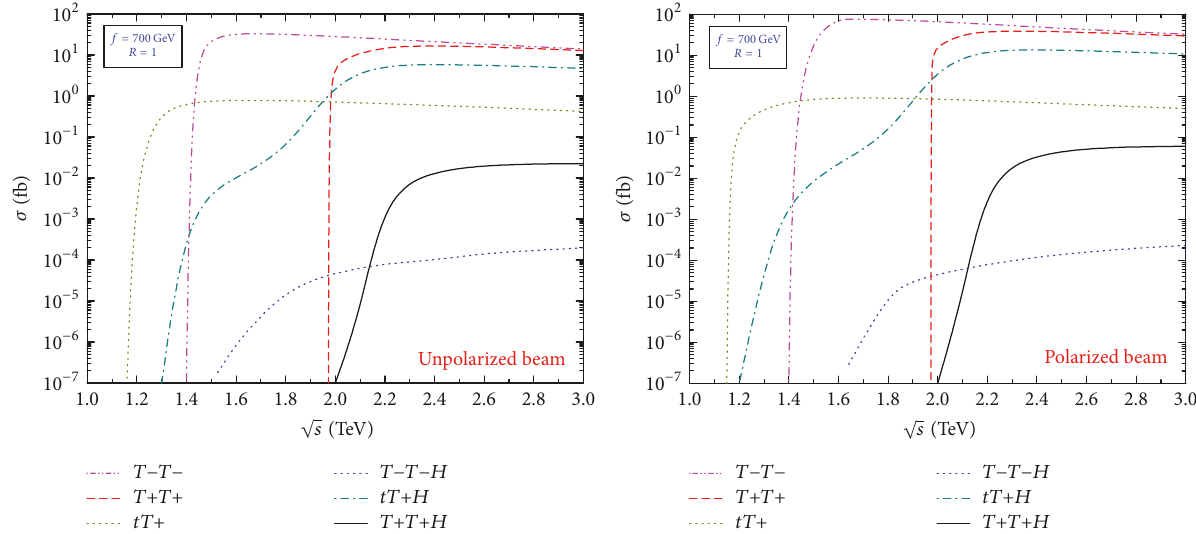
Figure 4: Top partner production cross sections as a function of √𝑠 for 𝑓 = 700 GeV, 𝑅 = 1 in 𝑒 + 𝑒 − collision with (un)polarized beam.